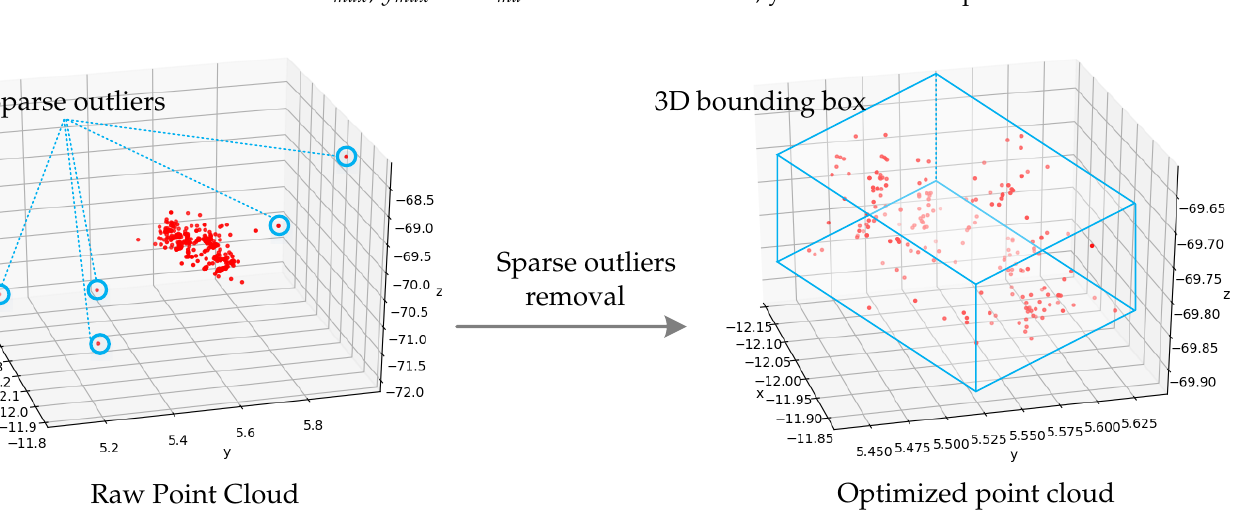
Figure 7. Road sign 3D localization refining. Sparse outliers (blue circles) are removed via the statistical analysis method. The 3D bounding box (blue box) is fitted based on the refined point cloud.